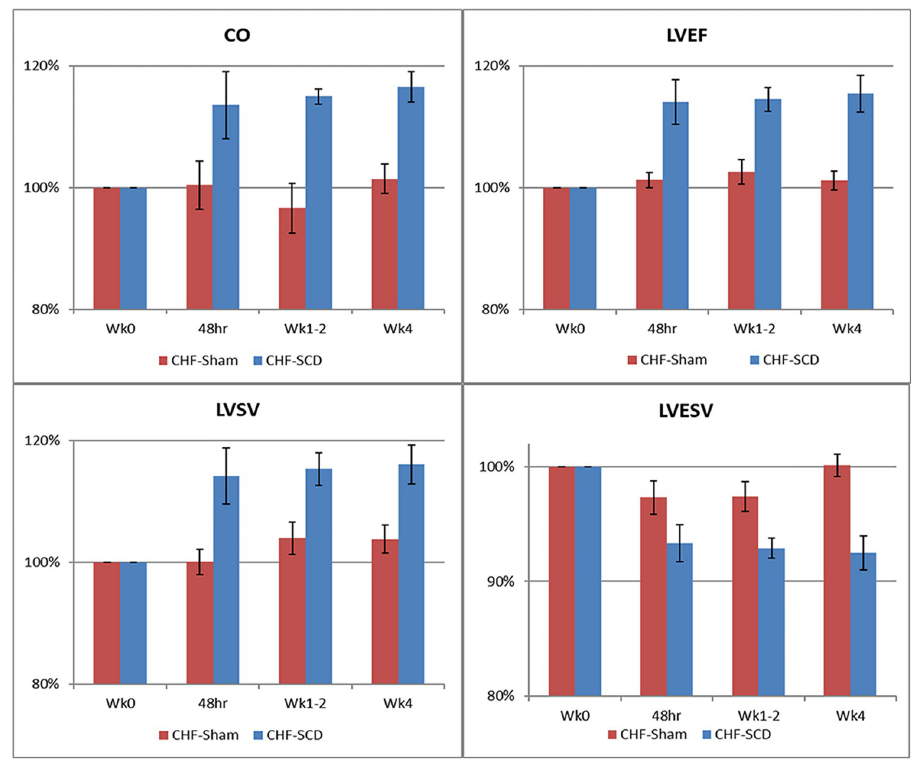
Fig 3. SCD treatment improves cardiac parameters compared to sham controls. SCD treatment (HF-SCD) significantly increased cardiac output (CO), left ventricular (LE) ejection fraction (EF), LV stroke volume (SV), and decreased LV end systolic volume (ESV) compared to sham treatment (HF-Sham) by ANOVA repeated measures over a 4 week time course; p < 0.02, p < 0.001, p < 0.01, p < 0.001,